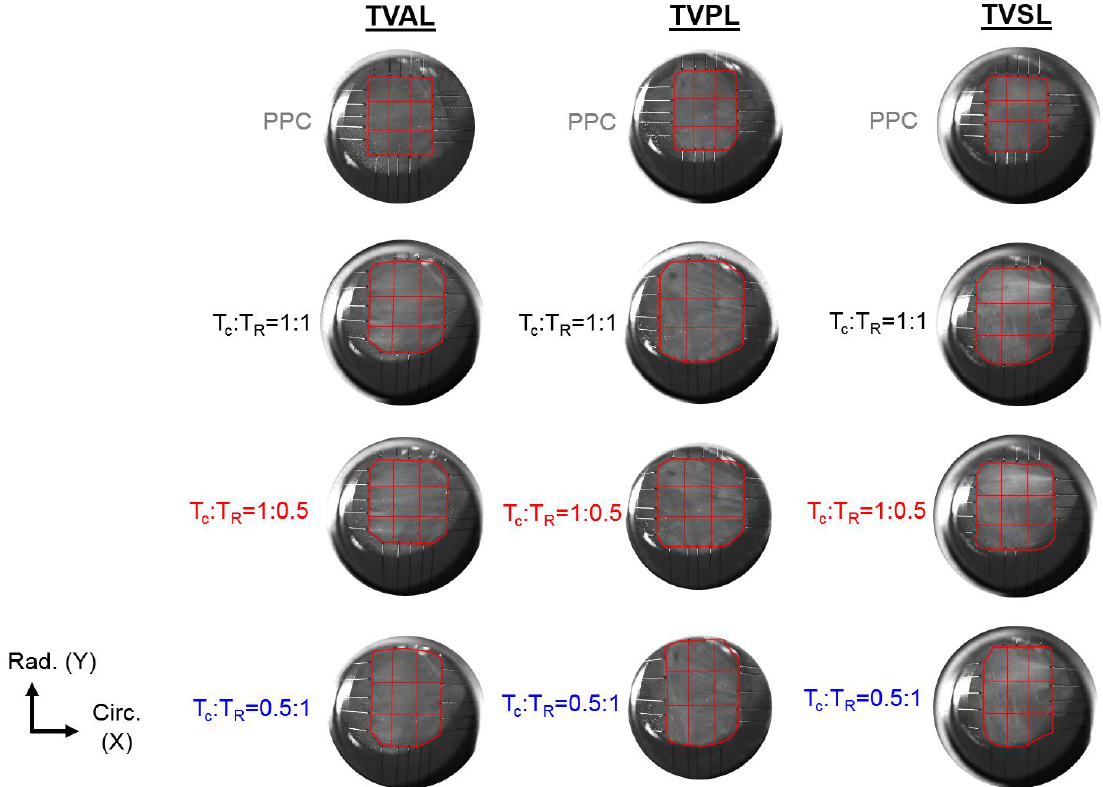
Figure 2. 3 × 3 grid sub-regions used for analyzing the spatial variations in the quantified load-dependent fiber orientation angle and the degree of optical anisotropy (DOA) for the anterior leaflet (TVAL), the posterior leaflet (TVPL), and the septal leaflet (TVSL) tissue specimens. (T C : circumferential tension, T R : radial tension, PPC: post-preconditioning).